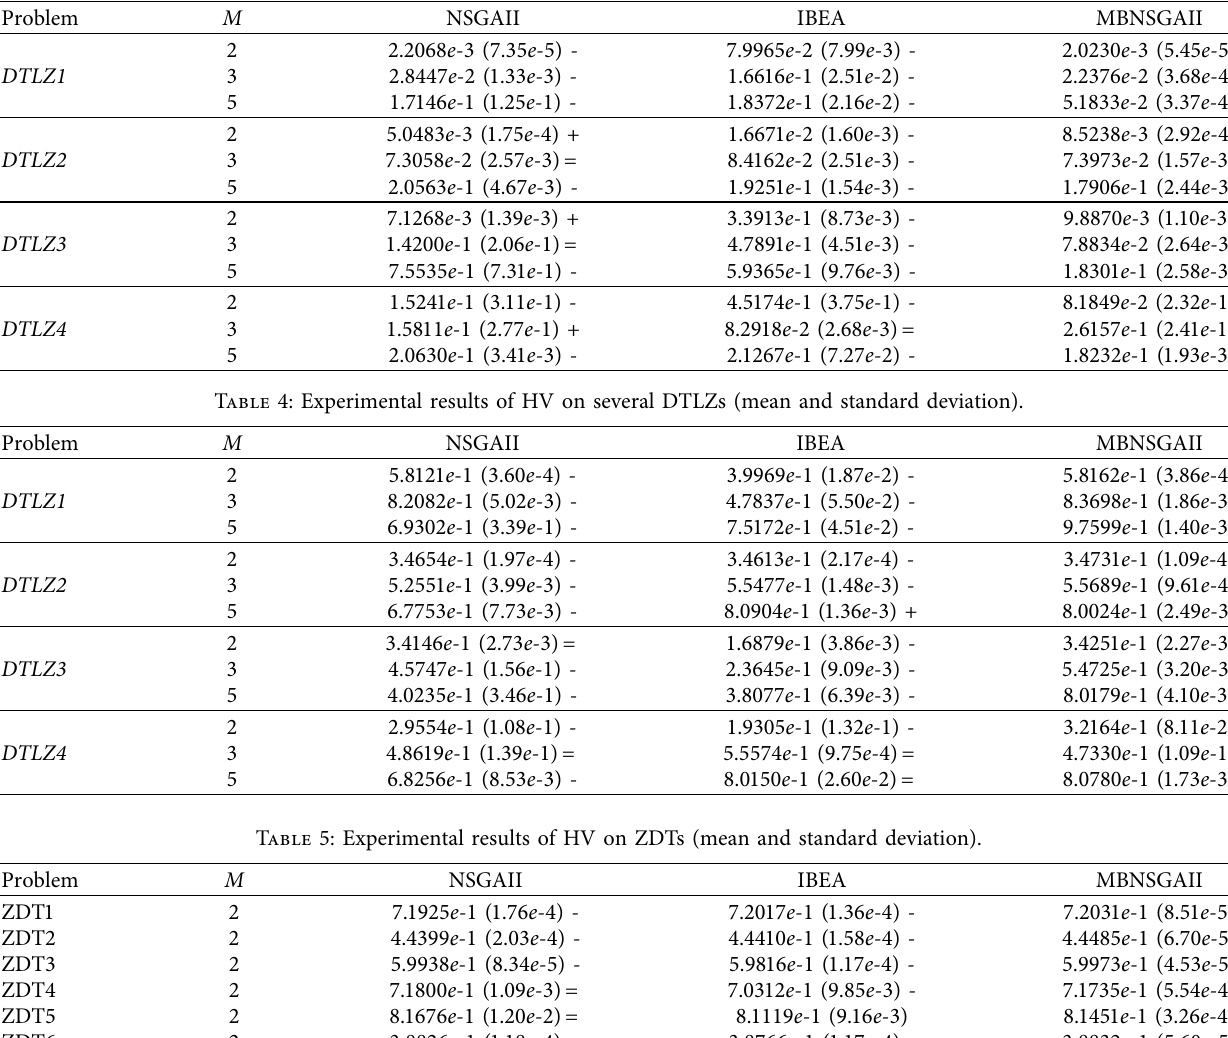
Table 3: Experimental results of IGD on several DTLZs (mean and standard deviation).